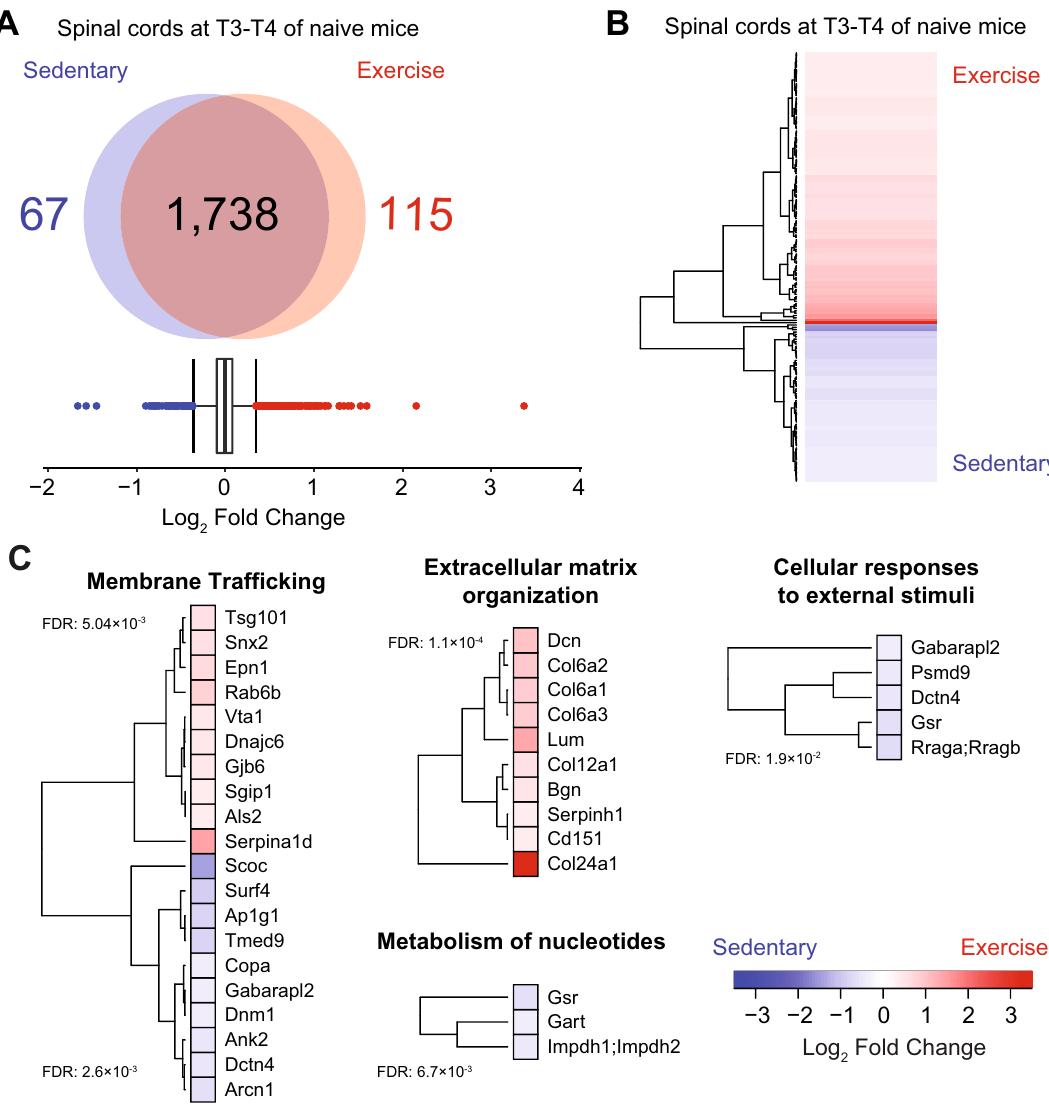
Figure 2. Effect of exercise on naïve spinal cord proteome after 4 days of running. Red, significantly elevated in the exercise group; Blue, significantly elevated in the sedentary group. ( A ) Quantification of differentially expressed proteins as determined by interquartile box plot analysis. A false discovery rate (FDR) of 1% was applied to the database search on MaxQuant. ( B ) Heatmap of differentially expressed proteins in naïve spinal cord tissue. ( C ) Heatmap of proteins and associated reactome pathways as determined by STRING (https:// string- db. org). A false discovery rate (FDR) for each pathway was added on the left of each heatmap. Interquartile box plot analysis was used for statistics. Data analysis was accomplished using the R software 32 . The plot was generated using the heatmap.2 function from the gplots package 34